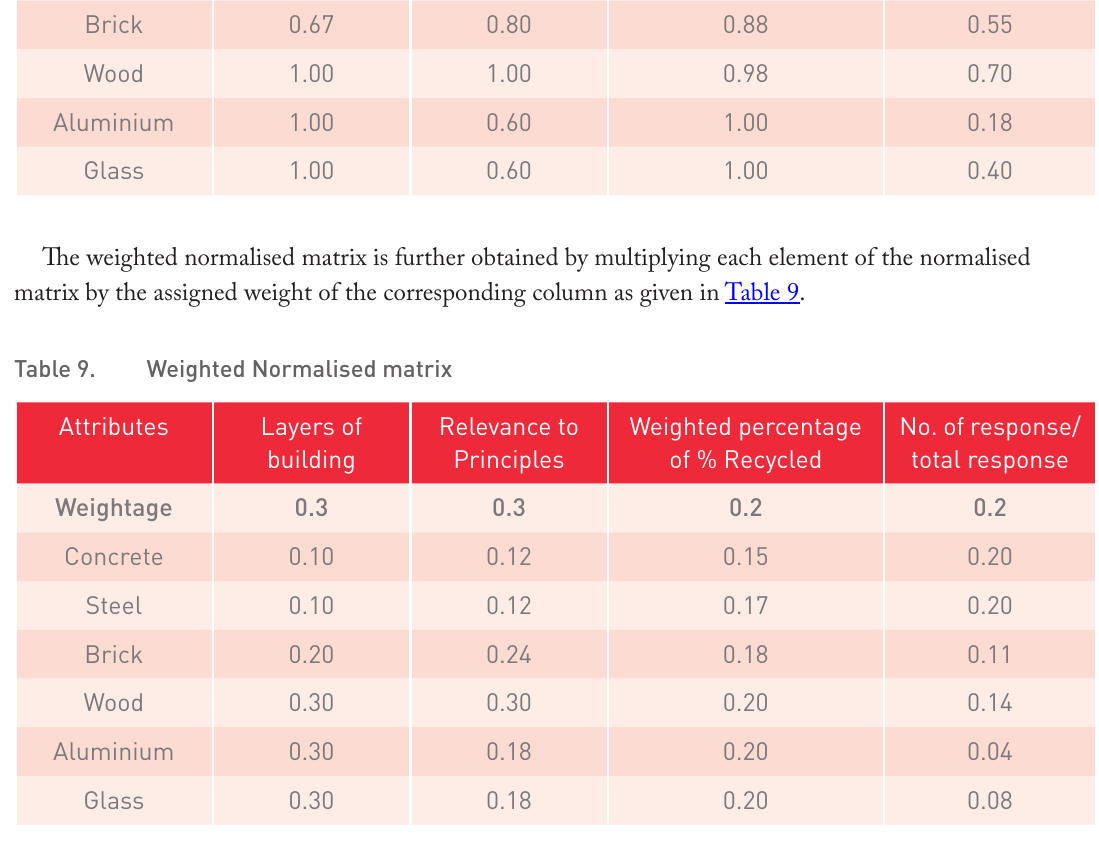
Normalised Matrix (R) Attributes Layers of building Weightage Concrete